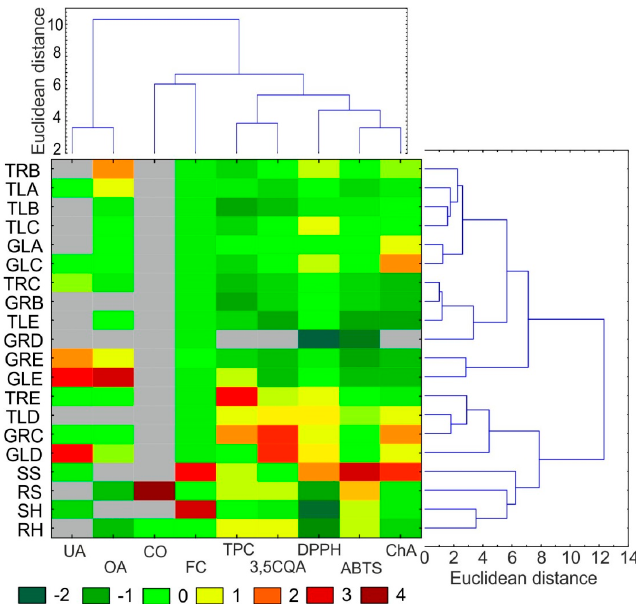
Figure 3. Heat map visualization of changes in the content of selected biological compounds and antioxidant activities shown in the columns for different materials from C. acaulis . The colors range from green (low abundance) to deep red (high abundance); * < LOD: under limit of detection (gray color). The right and top side of the figure shows hierarchical clustering dendrograms based on the